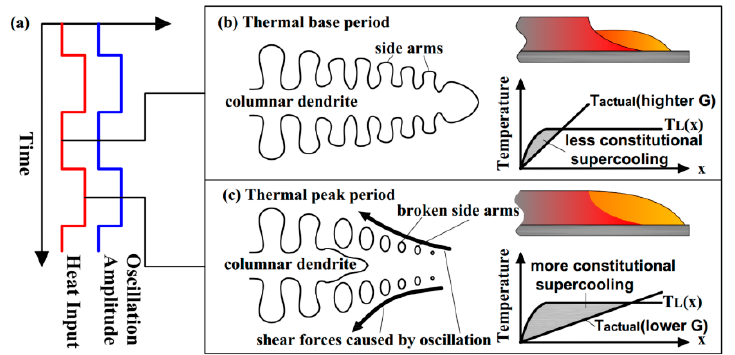
Figure 18. Thermal pulse helping grain refining: ( a ) process of the heat input and pool oscillation amplitude in DP-GMAW; ( b ) constitution supercooling in thermal base period; ( c ) constitution supercooling in thermal peak period.